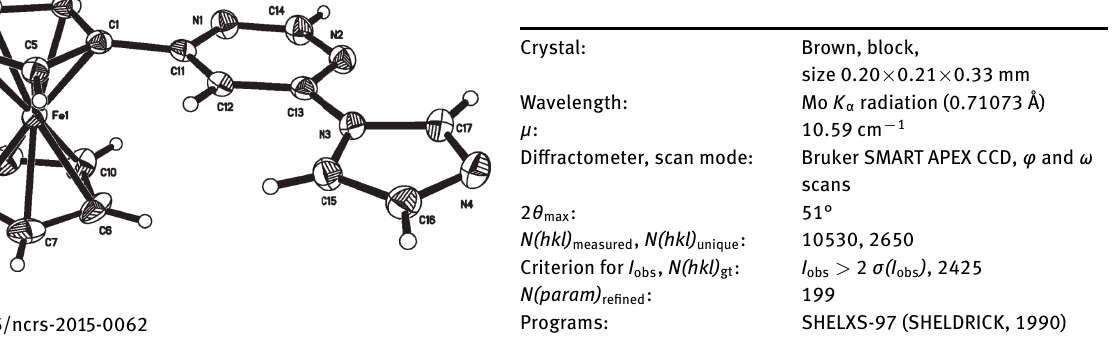
Table 1: Data collection and handling.